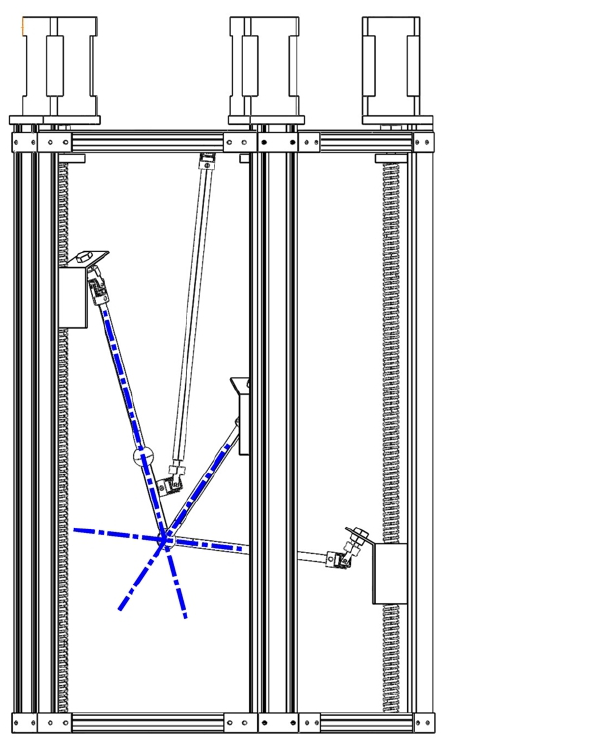
Figure 6. Singularity of improved